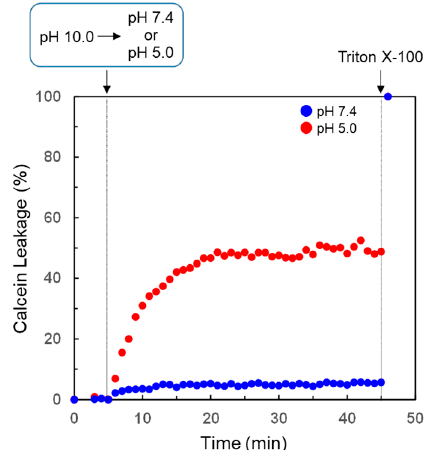
Figure 4. pH-selective calcein release behavior from liposomes anchoring the 1.0 mol% of rLPE-St. The calcein-entrapped liposomes were prepared at pH 10.0. After 5 min incubation, the pH was lowered to a value of 7.4 or 5.0.